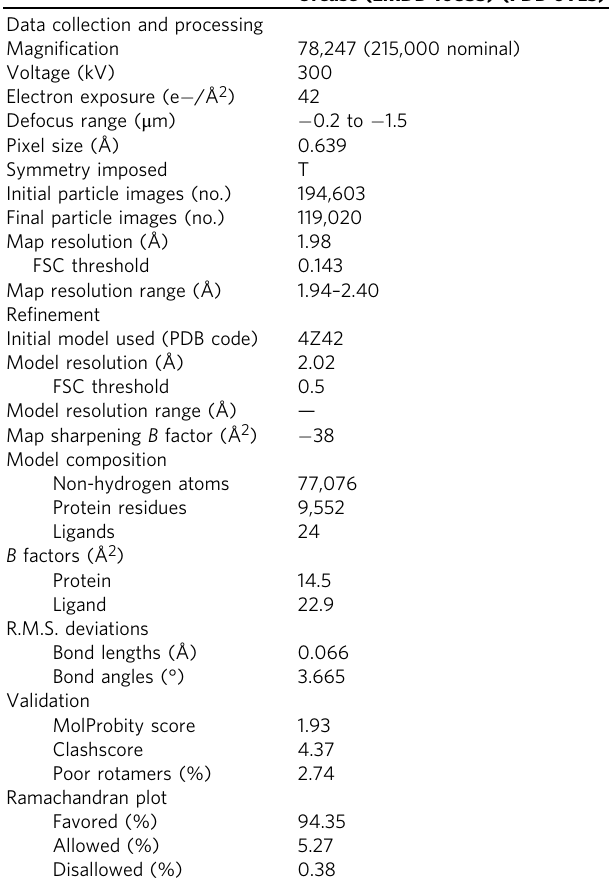
Table 1 Cryo-EM data collection, re fi nement and validation